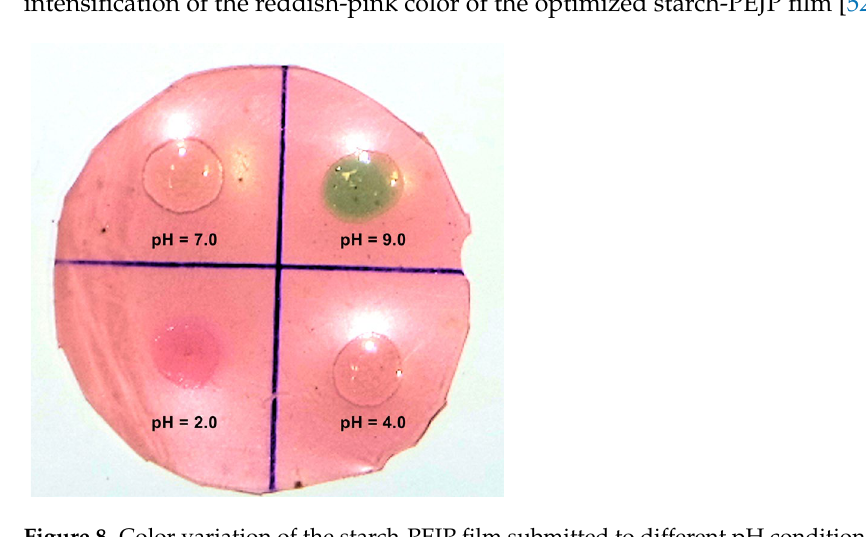
Figure 8. Color variation of the starch-PEJP film submitted to different pH conditions: photograph after 15 min of dropping the pH solution.